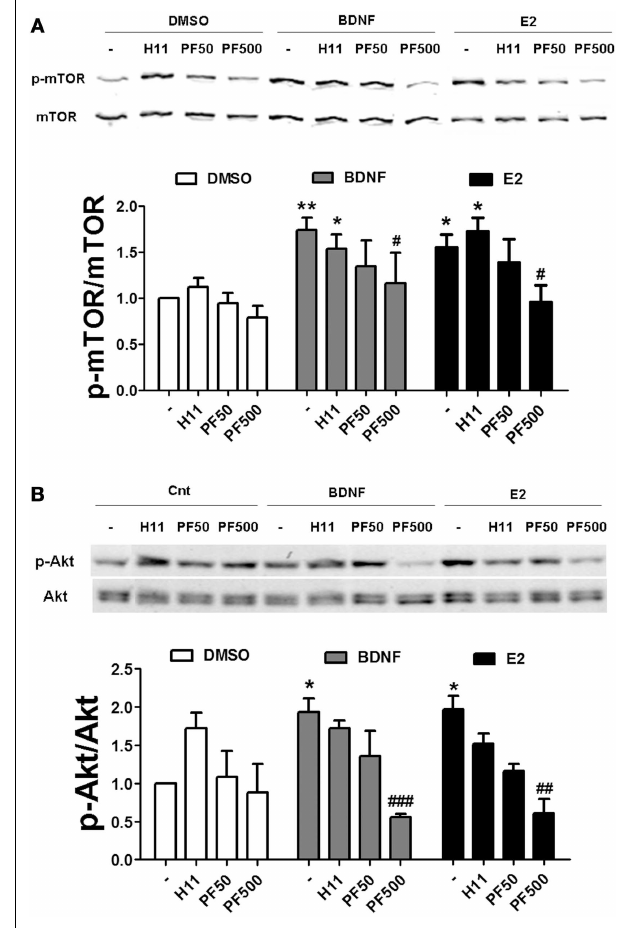
FIGURE 9 | Estradiol-induced mTOR signaling requires PAK activation . (A) Acute hippocampal slices were pre-treated with DMSO (Cnt), H1152 (H11, 200nM) or PF-03758309 (PF, 50–500nM) for 30min and then incubated with estradiol (E2, 10nM) or BDNF (100ng/ml) for an additional 30min. At the end of treatments, slices were homogenized and processed for western blot. Data are presented as the ratio (fold of control) of: (A) p-mTOR over total mTOR ( N = 3–13), (B) p-mTOR over total mTOR ( N = 3–4); * p < 0.05, ** p < 0.01, as compared to control (DMSO); # p < 0.05, ## p < 0.01, ### p < 0.001, as compared to E2 or BDNF alone (two-way